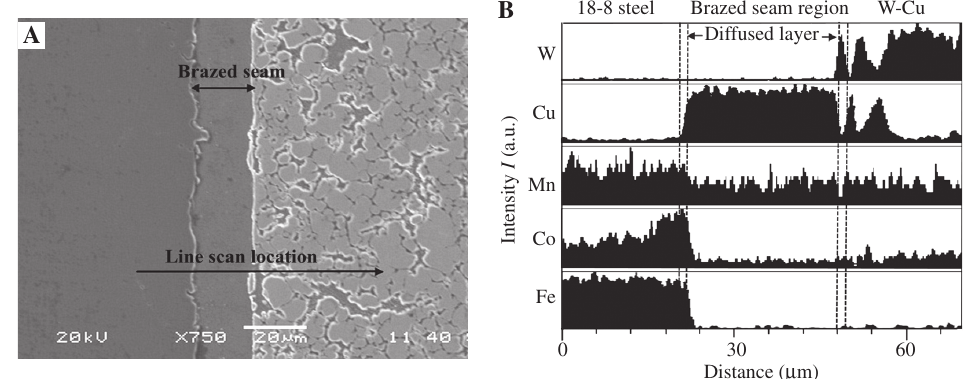
Figure 4 Element distribution near the interface of the W-Cu/18-8 brazed joint.